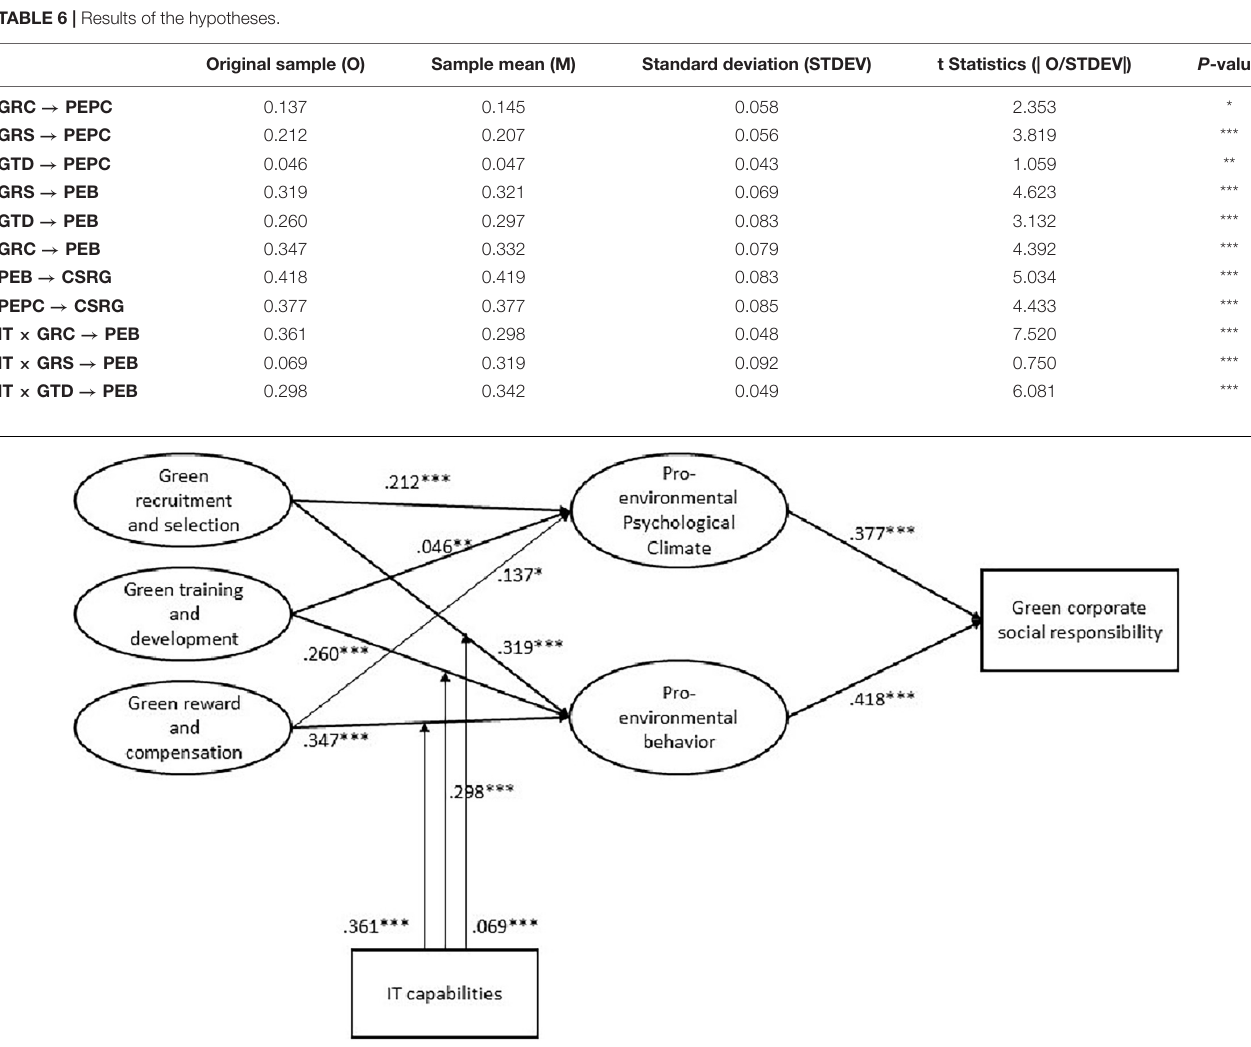
TABLE 6 | Results of the hypotheses.